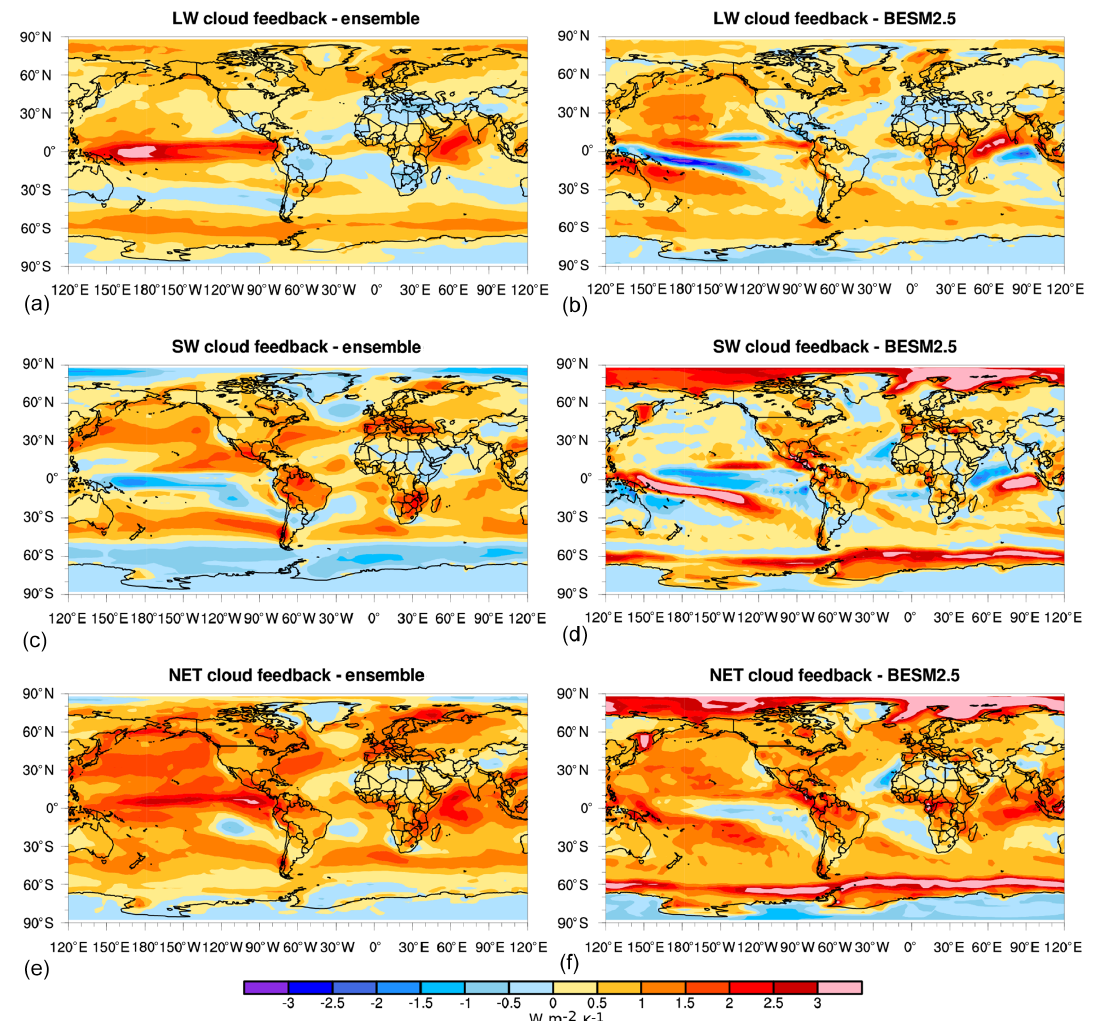
Figure 5. Cloud feedbacks calculated using the NCAR radiative kernel for the CMIP5 ensemble (a, c, e) and BESM-OA2.5 (b, d, f) . These results are based on the average from years